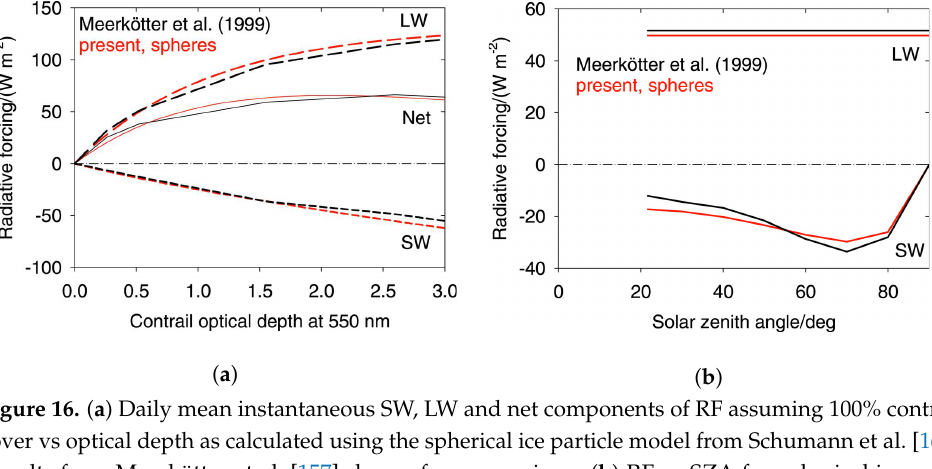
Figure 16. ( a ) Daily mean instantaneous SW, LW and net components of RF assuming 100% contrail cover vs optical depth as calculated using the spherical ice particle model from Schumann et al. [161]. Results from Meerkötter et al. [157] shown for comparison. ( b ) RF vs SZA for spherical ice parti- cles, with Meerkötter comparison shown. Reprinted with permission from [161]. Copyright 2022, American Meteorological